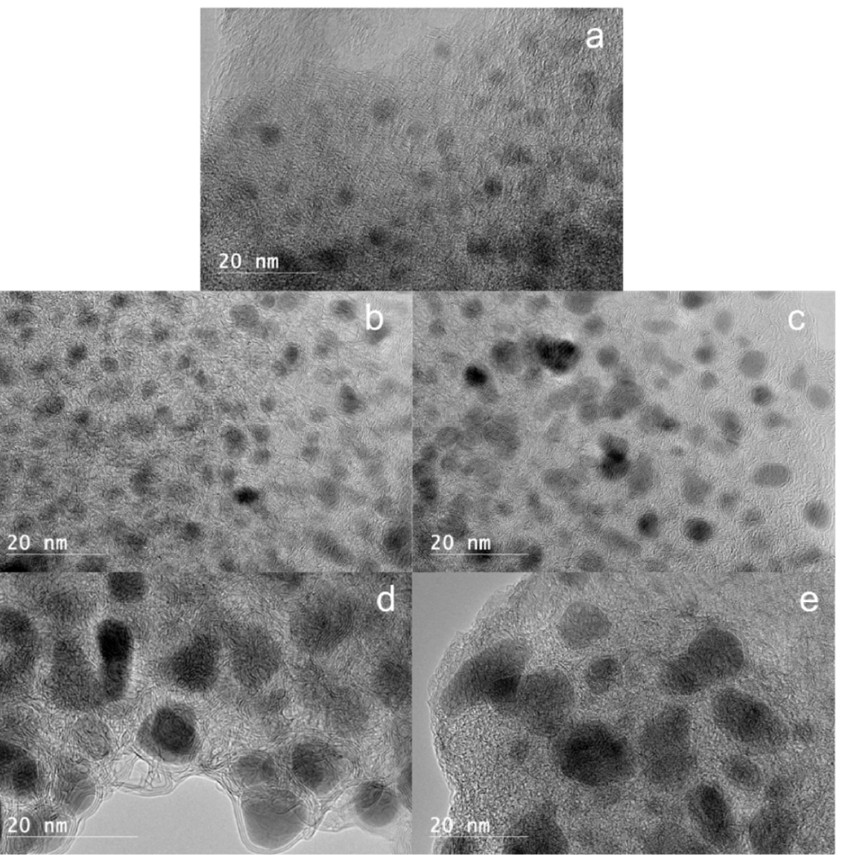
Figure 3. HRTEM images of Ni-lignin composites with different nickel loadings (( a ) 2.5%; ( b ) 5%; ( c ) 10%; ( d ) 15%; ( e ) 20%) catalytically graphitized under argon atmosphere at 900 °C.